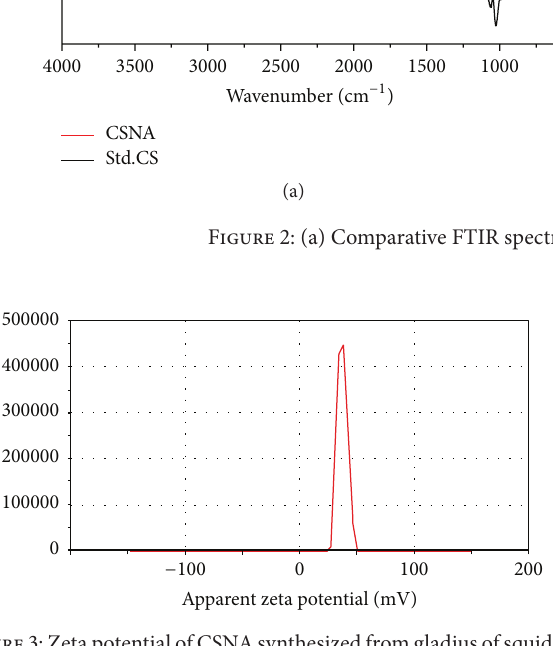
Figure 3: Zeta potential of CSNA synthesized from gladius of